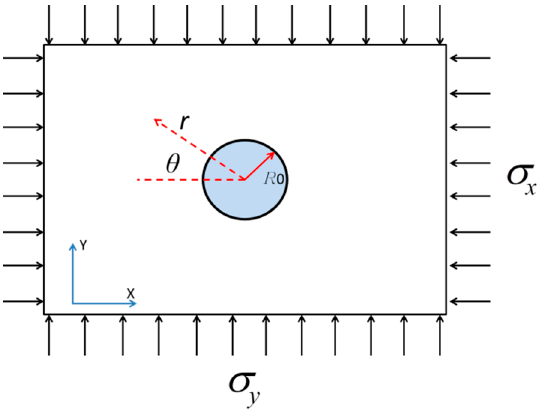
Figure 12. The analysis diagram of the surrounding rock of the shaft.